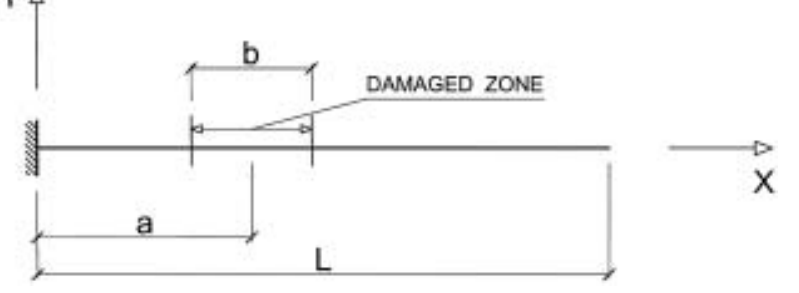
Fig. 2. Sketch of the model of the cantilever